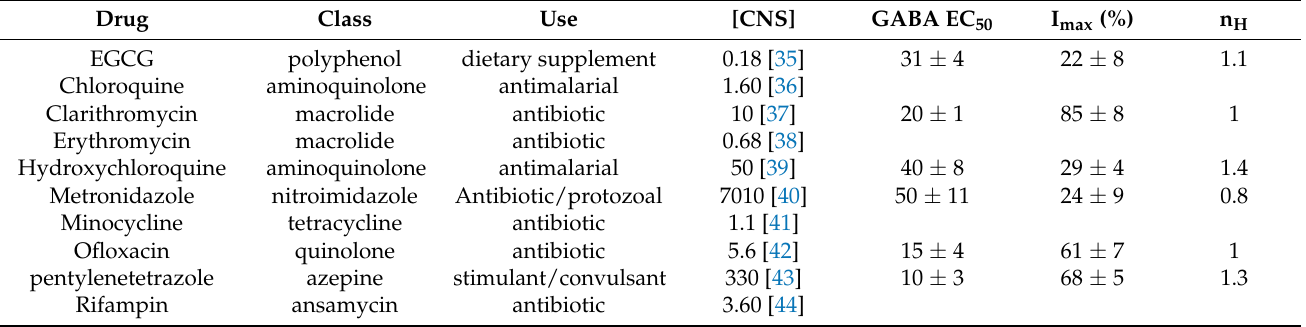
Table 1. Clinical and physiologic parameters for 10 compounds studied with GABA A receptors in this study. Concentrations are given in µ M. Data are mean ± standard error of the mean for 20–24